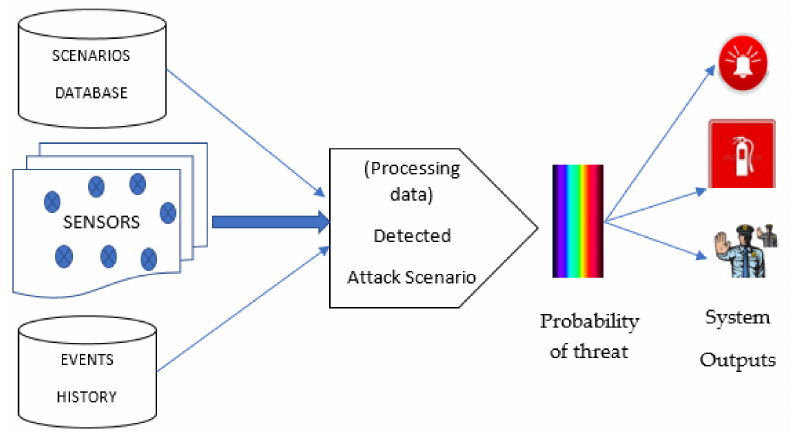
Figure 1. DETECT system